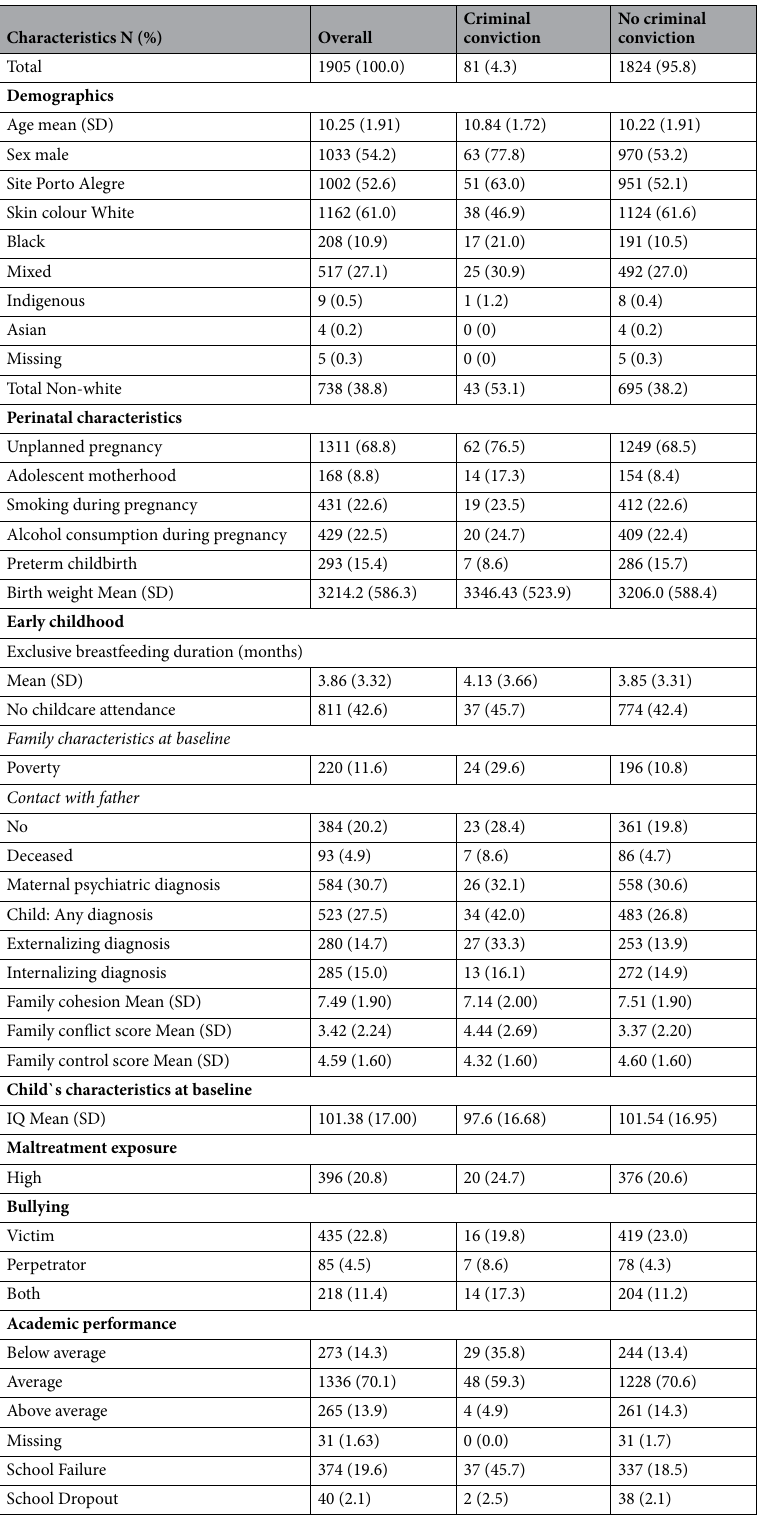
Table 1. Distribution of baseline characteristics by criminal conviction at 7-years follow-up BHRCS. IQ intelligence